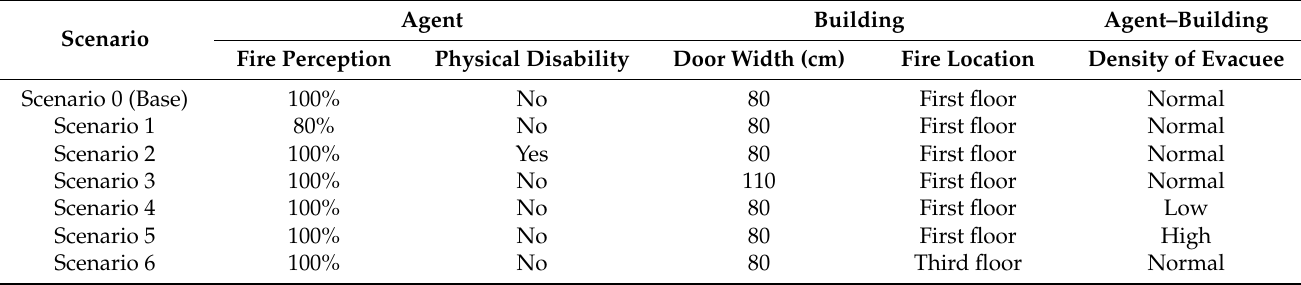
Table 3. Experiment design for each